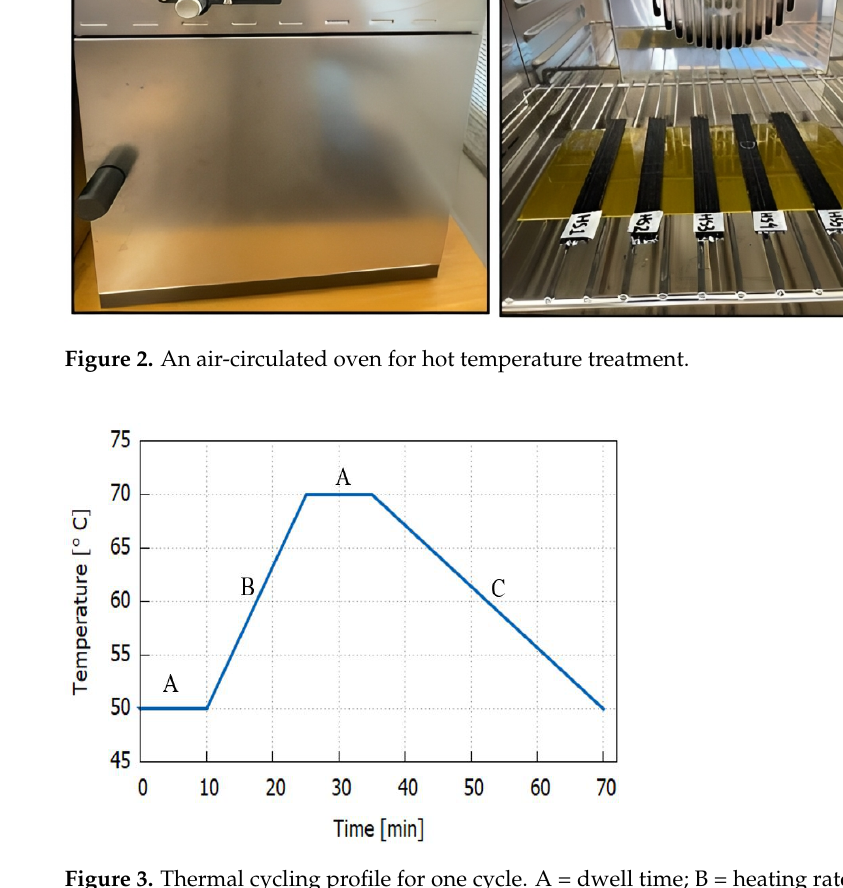
Figure 3. Thermal cycling profile for one cycle. A = dwell time; B = heating rate; C = cooling